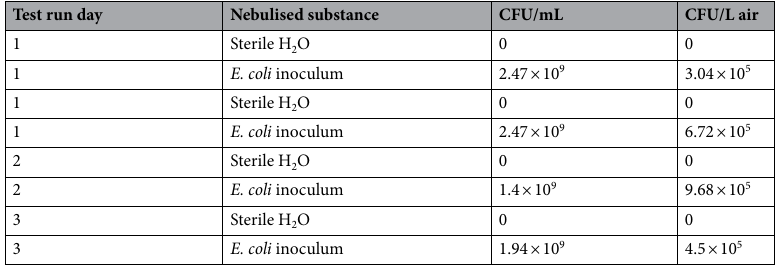
Table 2. Chamber evaluation. The objective was to determine the obtainable CFU/L air within the chamber and, additionally, the distribution and reproducibility hereof. Throughout all the test-runs, the Omron Ultrasonic Nebulizer NE-U17, used for aerosolisation, had the following set to 10: airflow, nebulisation volume and nebulisation time. All runs were succeeded by five minutes of ventilation of the chamber for safety reasons. AeroCollect air-samplers were utilised to determine the CFU/L air in duplicate. Quantitative PCR, performed in duplicates, was used to determine the E. coli CFU/L air. The mean of the measurements is presented. CFU colony forming unit, E. coli Escherichia coli.